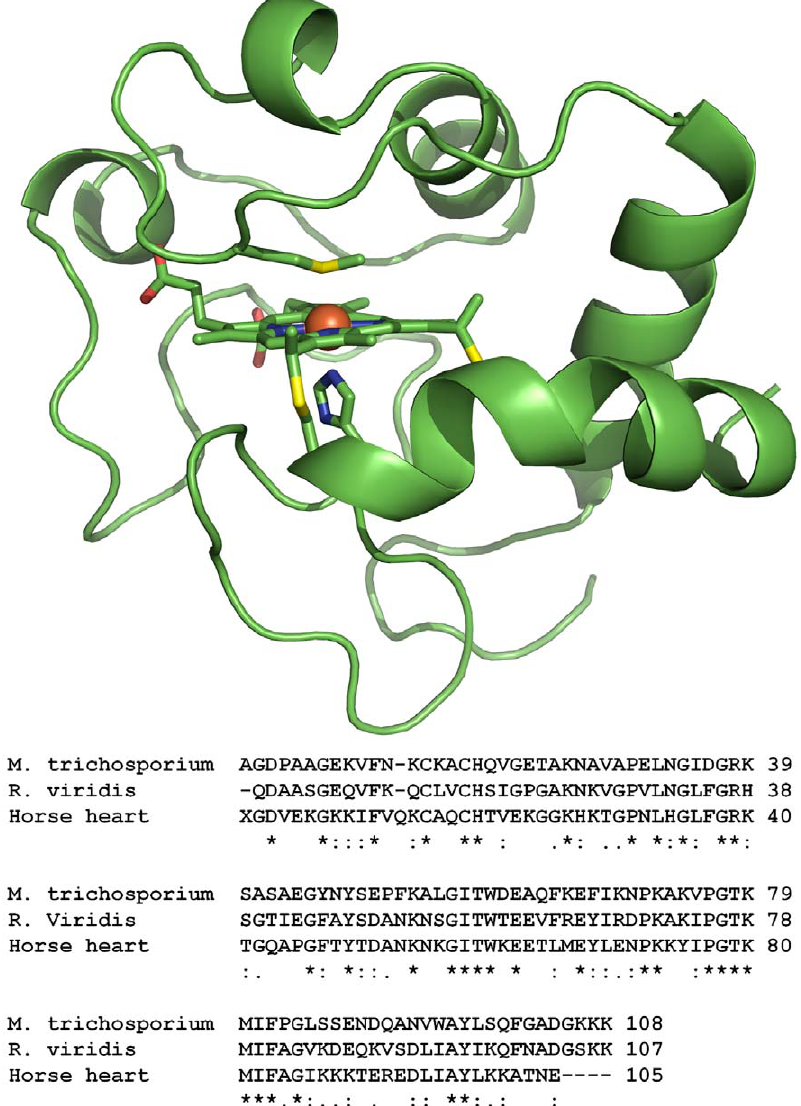
Figure 3. Homology model of cytochrome c -554 from Methylosinustrichosporium OB3b. The structure template used is cytochrome c 2 from Rhodopseudomonas viridis (PDBid: 1CO6) [37]. The amino acid sequence of these two proteins has 56 (52%) identical residues and a total of 74 (69%) positives (identical residues or conservative mutations). High similarity with the mitochondrial cytochrome c is found, and sequence alignment reveals a highly conserved region in the loop containing the heme axial ligand methionine. The molecular drawing was made with Pymol, DeLano Scientific, San Carlos, CA.